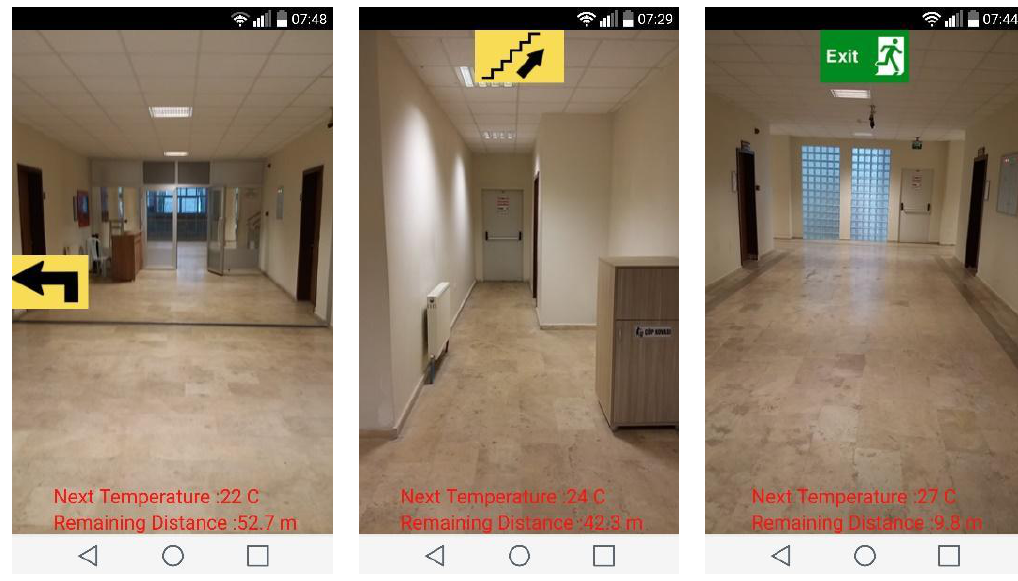
Figure 9. Some screenshots taken from Evacuee-1’s smartphone.